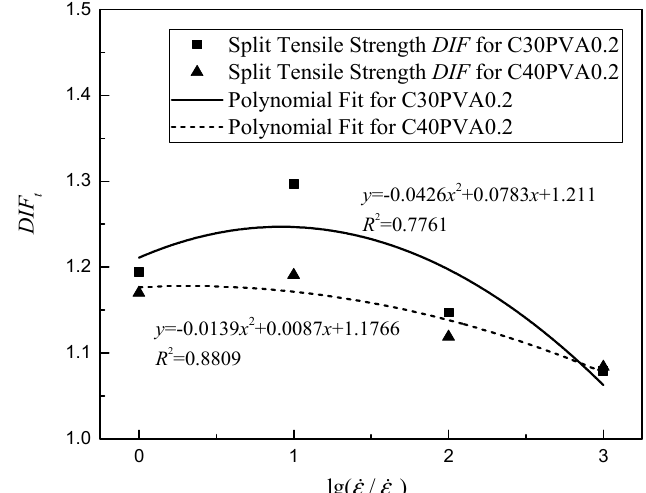
Figure 9. Fitting curves of split tensile strength DIF t for C30PVA0.2 and C40PVA0.2.